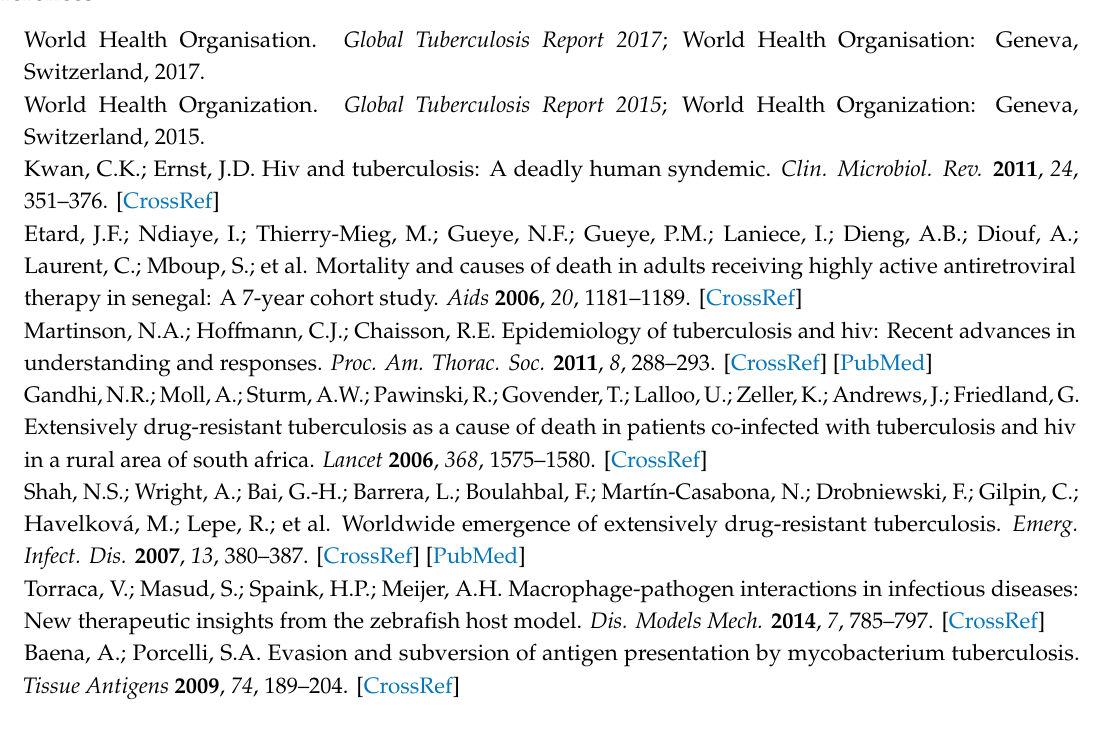
Figure S1. 1 HNMR spectra of raw MPI without any drug attachment; Figure S2. (A–C) 1 HNMR spectra of PCA, amine modified MPI and MPIEDPCA; Figure S3. FTIR spectra of PCA; Figure S4. Change in zeta potential due to modification of MPI; Figure S5. 1 HNMR spectra of reaction product of unmodified MPI and PCA activated with EDC / NHS; Figure S6. 1 HNMR spectra of reaction product of unmodified MPI and PCA without EDC / NHS; Figure S7. 1 HNMR spectra of reaction product of amine modified MPI with PCA without EDC / NHS (MPIED + PCA); Figure S8. HPLC chromatogram of PCA; Figure S9. Calibration curve for the pure PCA standard; Figure S10. UV spectrum of both PCA (10 µ g) and MPIEDPCA (equivalent amount of PCA); Table S1. Kinetic release models for